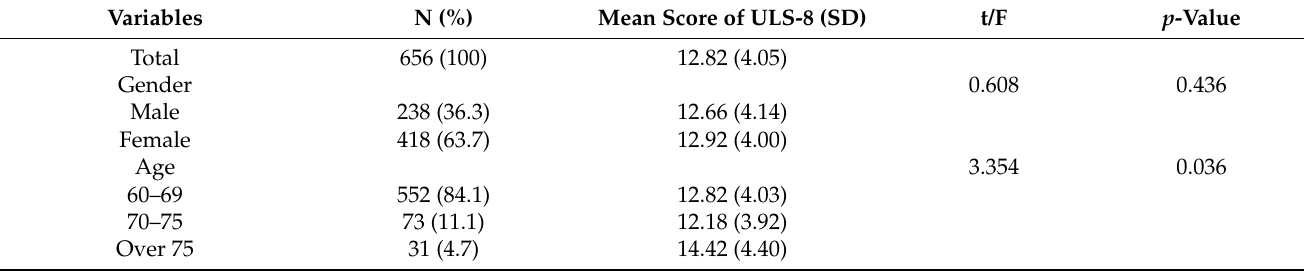
Table 1. Description and univariate analysis of loneliness among the MEFC in Jinan, Shandong Province,